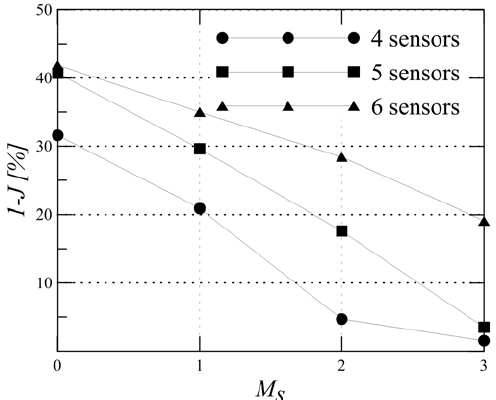
Figure 11. Performance of four-, five- and six-sensor combinations for increasing sensor malfunctioning M s in the panel represented in Figure 7. P sd = 10% µ and e T = 20